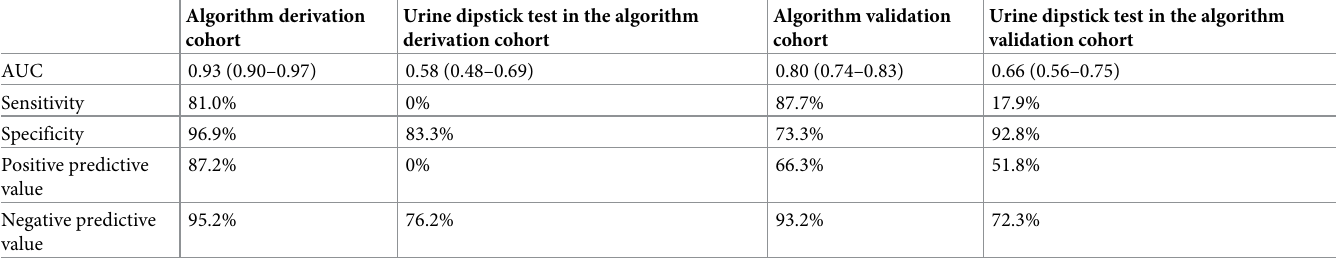
Table 7. Diagnostic performance of the algorithm versus urine dipstick in both the derivation and validation cohort. Algorithm derivation Urine dipstick test in the algorithm cohort derivation cohort